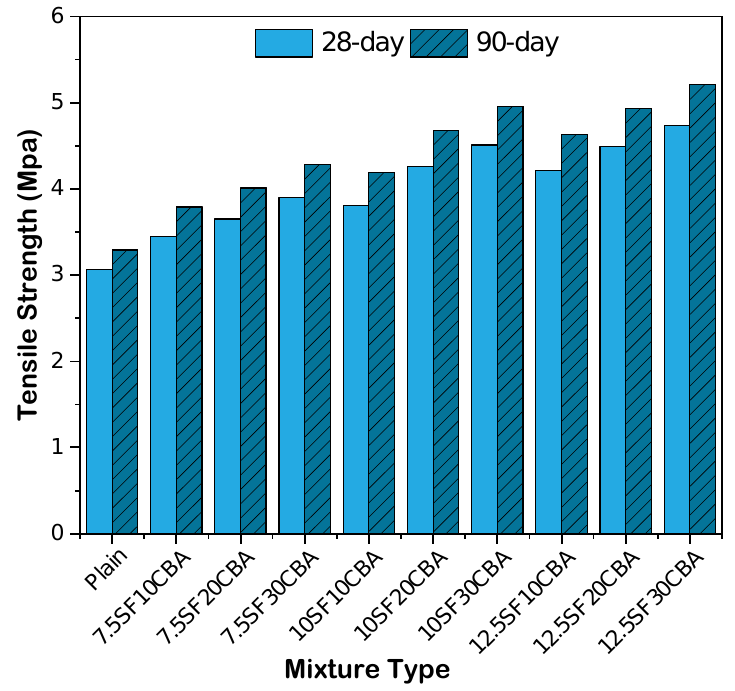
Figure 10. Tensile Strength of concrete mixed with CBA and SF.